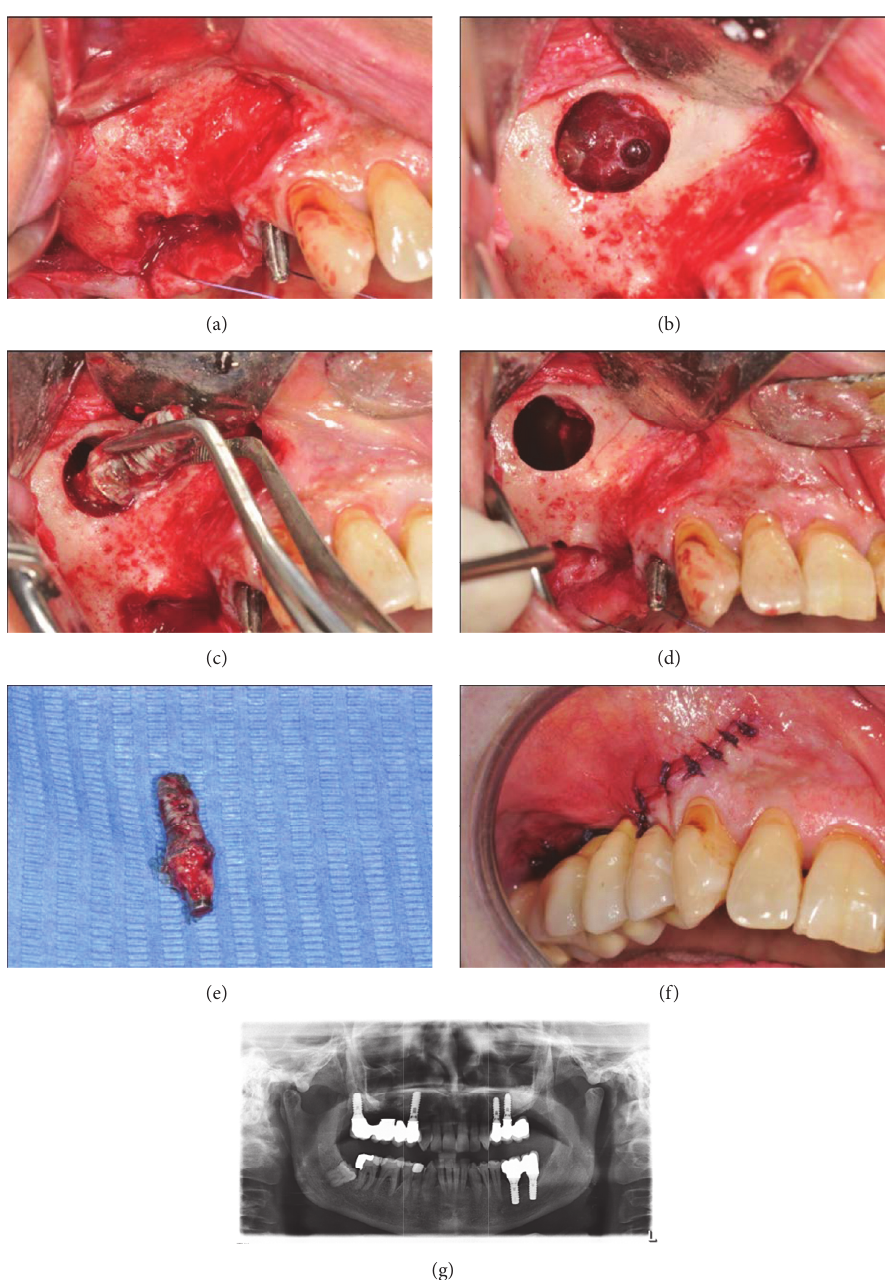
Figure 3: (a) Clinical situation after the flap was raised. (b) Photograph of the right maxillary sinus after a lateral window access showing sinusitis secondary to implant displacement. (c) Picture of the implant removal with forceps. (d) Maxillary sinus situation after its surgical revision. (e) Extra-oral view of the removed implant. (f) Clinical situation after the flap was sutured and the fixed prosthesis was cemented. (g) Radiographic view of the right maxillary sinus soon after the implant was